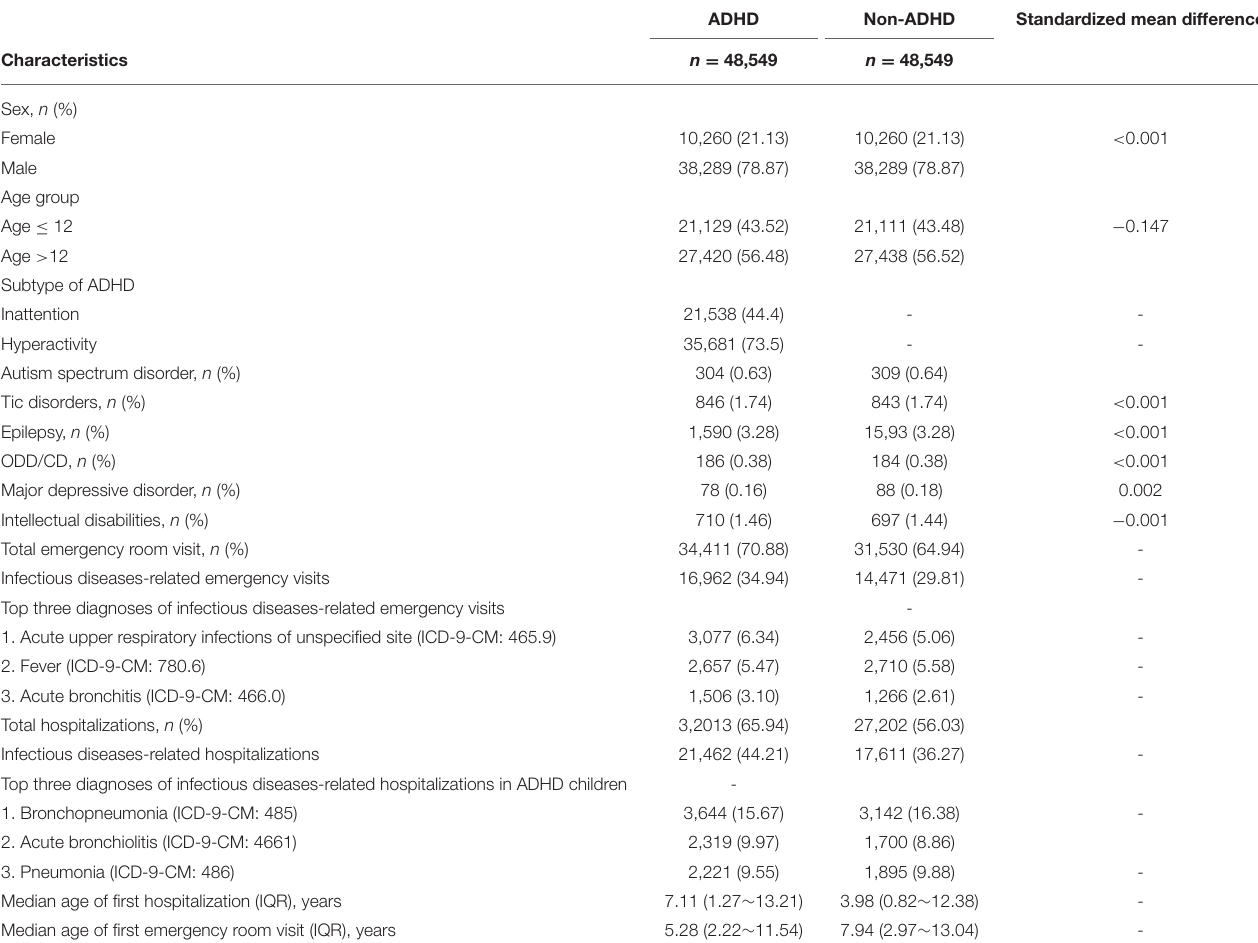
TABLE 1 | Demographic characteristics of ADHD and non-ADHD youths after propensity score matching.